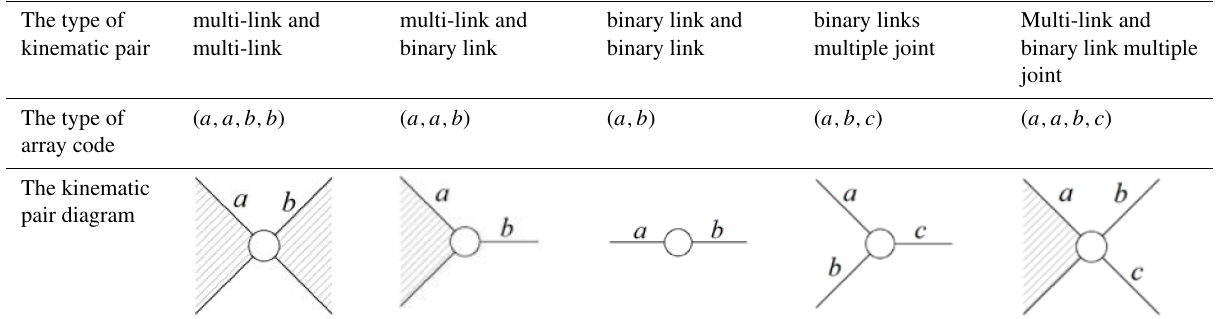
binary link and